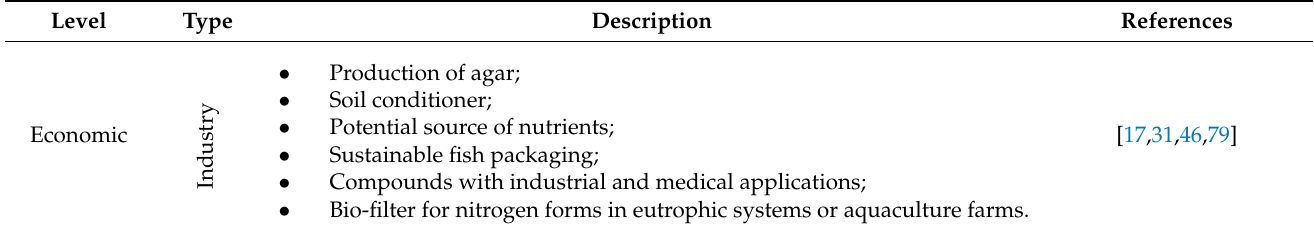
Table 2. Application and effects recorded for Gracilaria vermiculophylla present in non-native areas. Ecological effects are strongly linked to its ecosystem engineer performance, and environmental risks are associated with high-biomass episodes of this